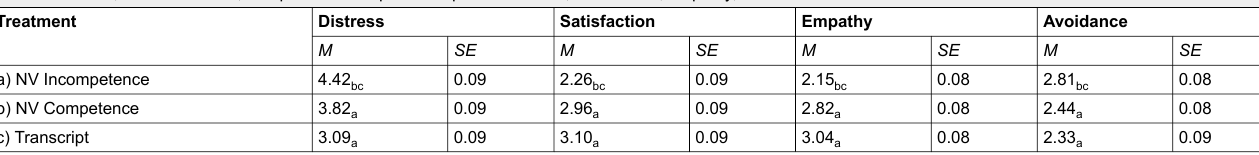
Table 3: Means, standard errors, and pairwise domparisons: patient distress, satisfaction, empathy, and